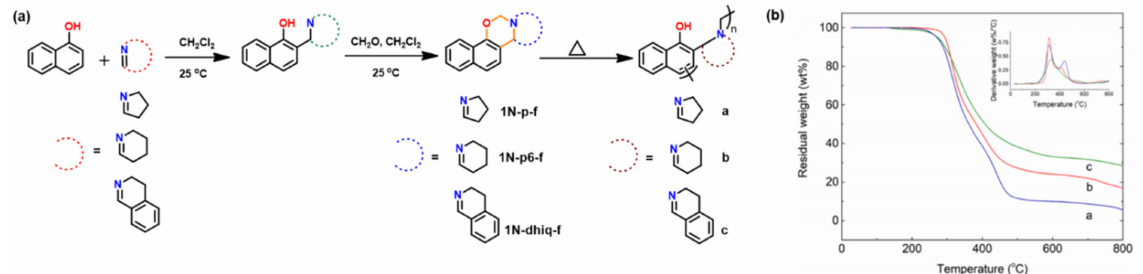
Figure 32. ( a ) Synthesis of fused ring benzoxazine monomer and proposed polymerization, ( b ) TGA thermograms of ( a ) poly(1NP-p6-f), ( b ) poly(1NP-p-f) and ( c ) poly(1NP-dhiq-f). Inset shows the derivative of the weight loss of poly(1NP- p6-f) (green line), poly(1NP-p-f) (blue line) and poly(1NP-dhiq-f) (red line) as a function of the temperature [254]. Copyright 2017. Reproduced with permission from American Chemical Society.